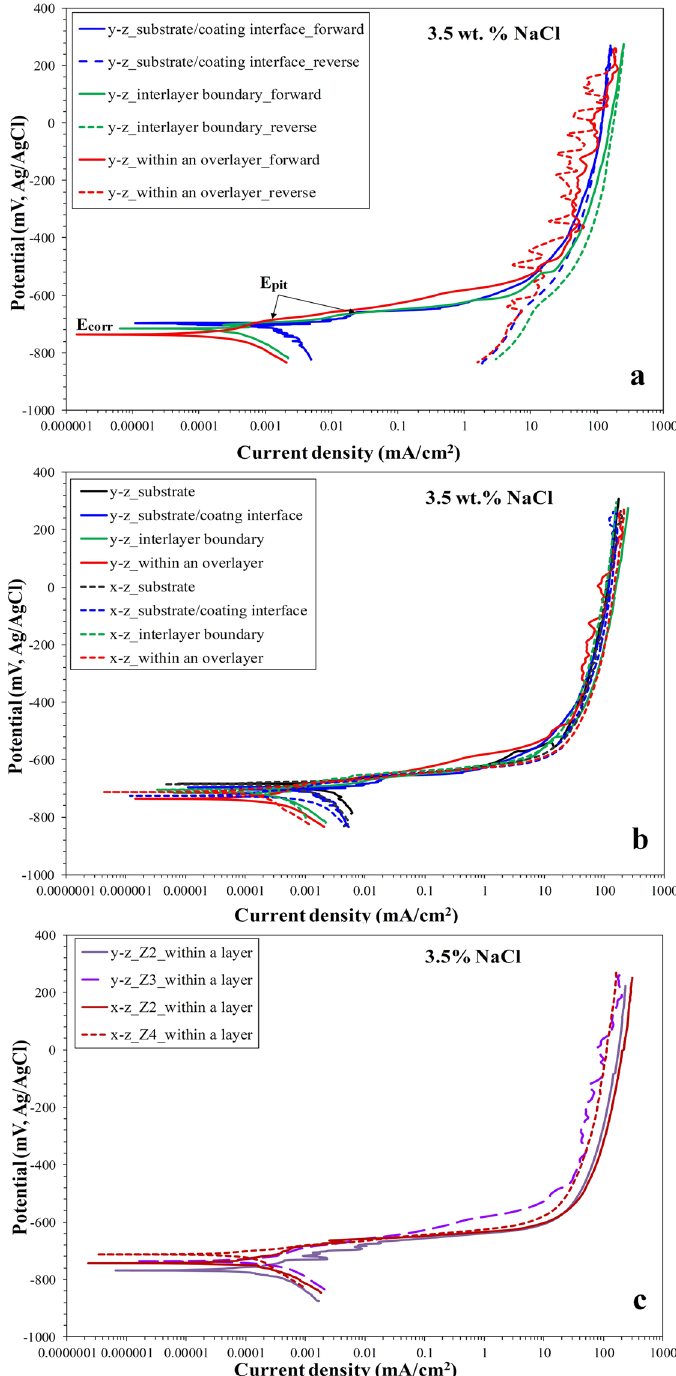
Fig. 6 Polarization curves. a Cyclic polarization curves of the different zones of the AM structure (surfaces parallel to the y-z plane); b Comparison of forward polarization curves of surfaces parallel to the y-z and x-z planes; c Comparison of forward polarization curves of surfaces parallel to the y-z and x - z planes at distances Z2: ~2.0 cm, Z3: ~4.0 cm and Z4: ~5.5 cm from the substrate (3.5 wt.% NaCl, 25 °C). detected by EDS. Therefore, the surface material removal in Fig. intergranular degradation hints the presence of intergranular 7c, d can be attributed to the intergranular dissolution of the (Al, submicron/nano-precipitates. Mg) matrix and the subsequent dislodgement of the dispersed Figure 8a, b reveal pitting around fi ne and submicron particles fi ne particles. IGC is associated with the increased IG presence of at the interlayer boundaries (zone c) and within the individual Fe (Fig. 8b, sp. *). overlayers (zone d), respectively. EDS analysis reveals that the The observations in this section manifest that the Al(Fe, Mn)Si- large majority of the intermetallic particles are of the type Al-Fe- based intermetallic particles play the most important role in the Mn-Si, Al-Fe-Mn, Al-Fe-Mn-Cr-Si (Fig. 8a, sp. + , Fig. 8b, sp. • ). Al-Fe- corrosion behavior of the system. The coarseness of the Al(Fe, Mn) Mn-Ti-Cr-Si and Al-Ti-Fe-Mn intermetallics have also been Published in partnership with CSCP and USTB npj Materials Degradation (2021)